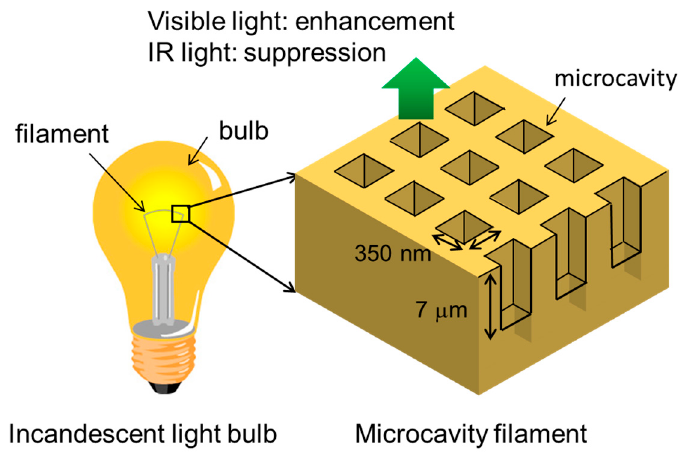
Figure 1. The concept of a microcavity lamp: an incandescent light bulb with a microcavity array filament acting as a refractory metasurface.